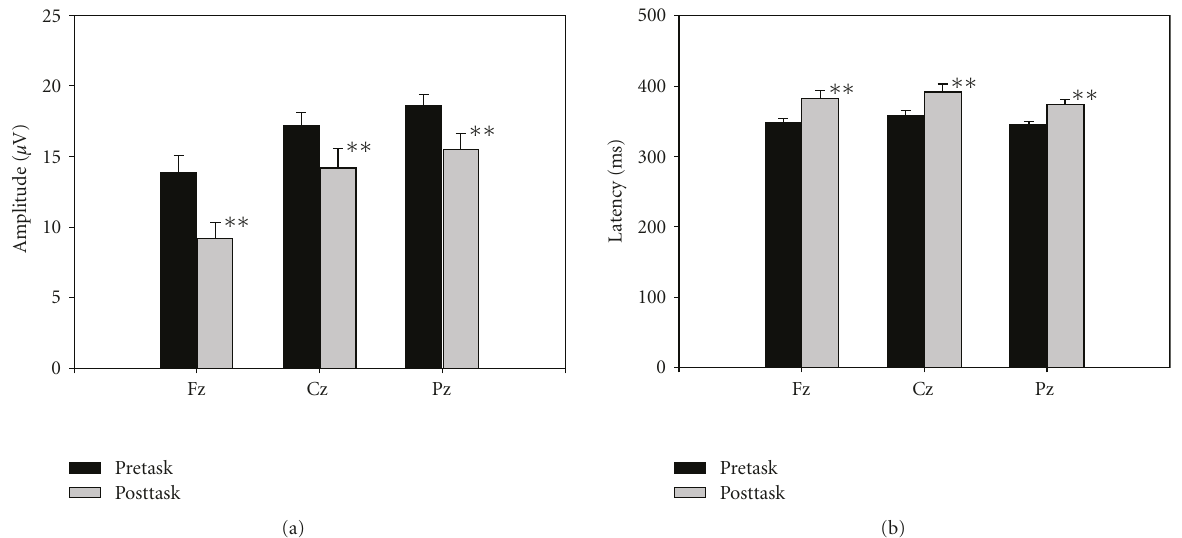
Figure 5: Comparison of P300 amplitude and latency between two sessions. Pretask (before task), posttask (immediately after task). ∗∗ P < . 005, statistical significance of di ff erence between two